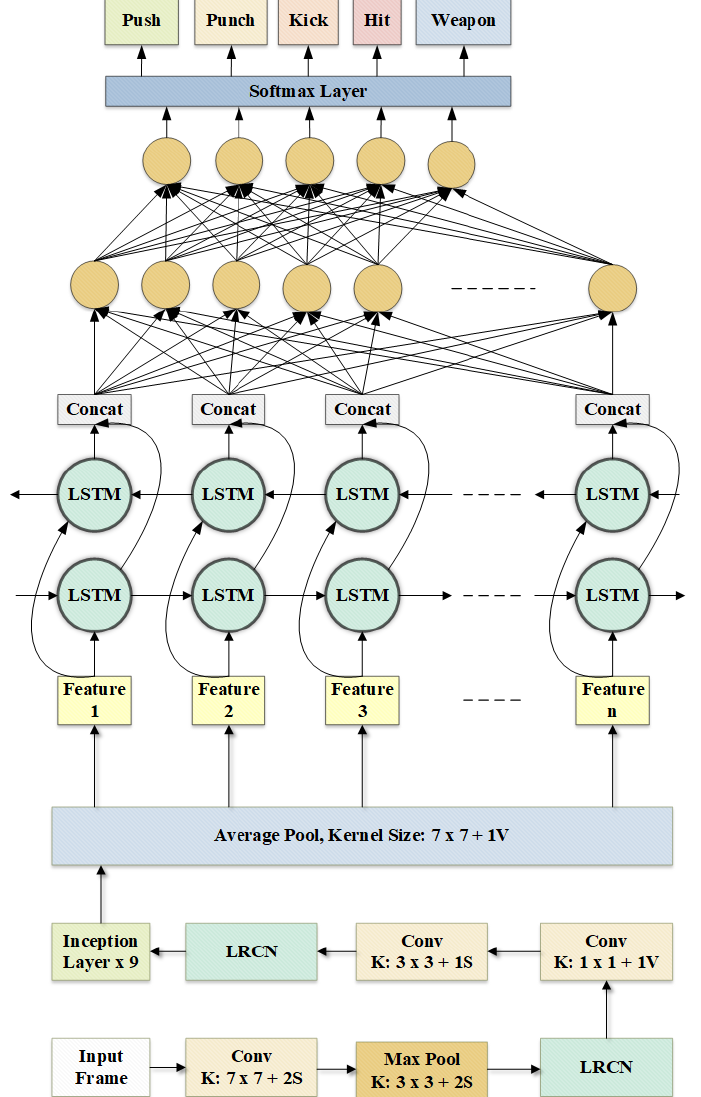
Figure 2. The GoogleNet–BiLSTM